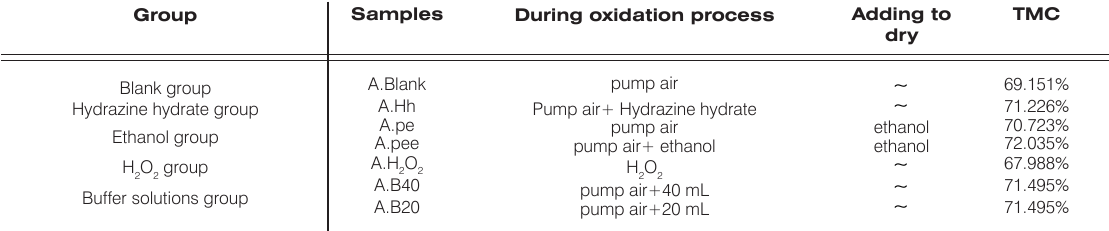
Table 2. The all aqueous solution oxidation method and TMC of samples Group